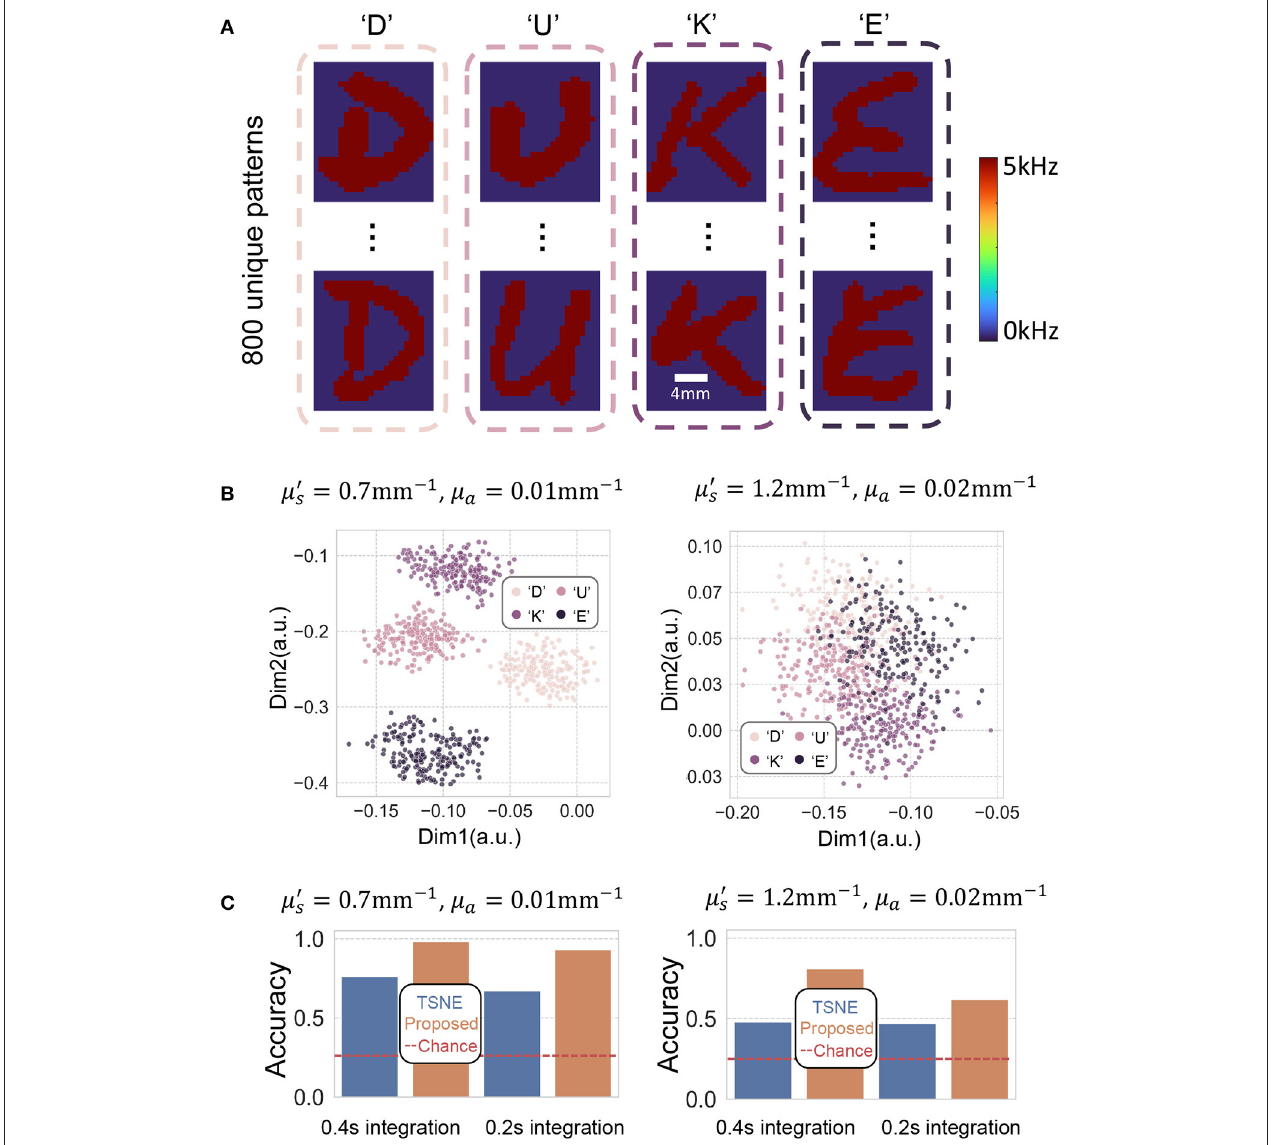
FIGURE 5 | (A) Depicts some representative spatially different letter-shaped decorrelation events we attempt to classify. The perturbed decorrelations are generated by flipping the DMD at 5 kHz. (B) Plots two of the eight dimensions of the embedding using our proposed method. The autocorrelations were computed using 0.4 s integration time. (C) Barplots of the classification accuracy of TSNE and proposed method using 0.2 and 0.4 s integration time. The red dashed line plots the baseline by random guess, which is 0.25 for a quaternary classification